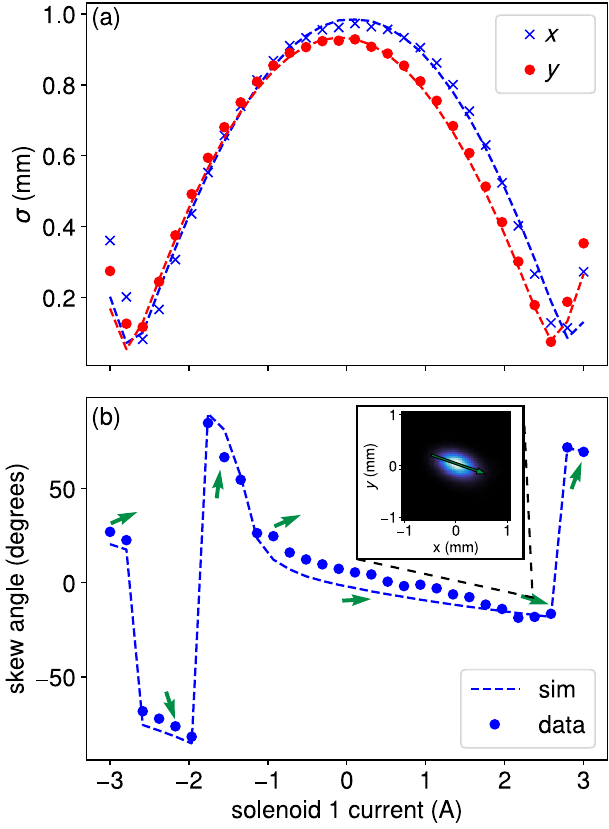
FIG. 3. An example of the effects of the stray quadrupole moments in S1 on the (a) transverse beam size and (b) transverse beam shape. The beam shape is quantified with the skew angle of the beam profile. The green arrows provide a visualization of the directions associated with the skew angles. The dashed lines represent fits done with GPT and show good agreement with the experimental data. Inset: Example of a beam with an evident skew. These data are taken on an intermediate viewscreen immediately following